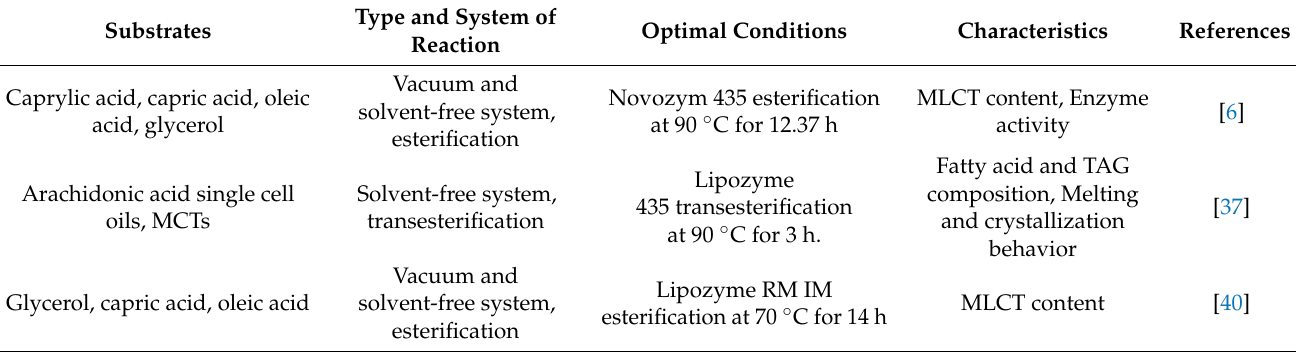
Table 3. Current enzymatic synthesis methods to produce